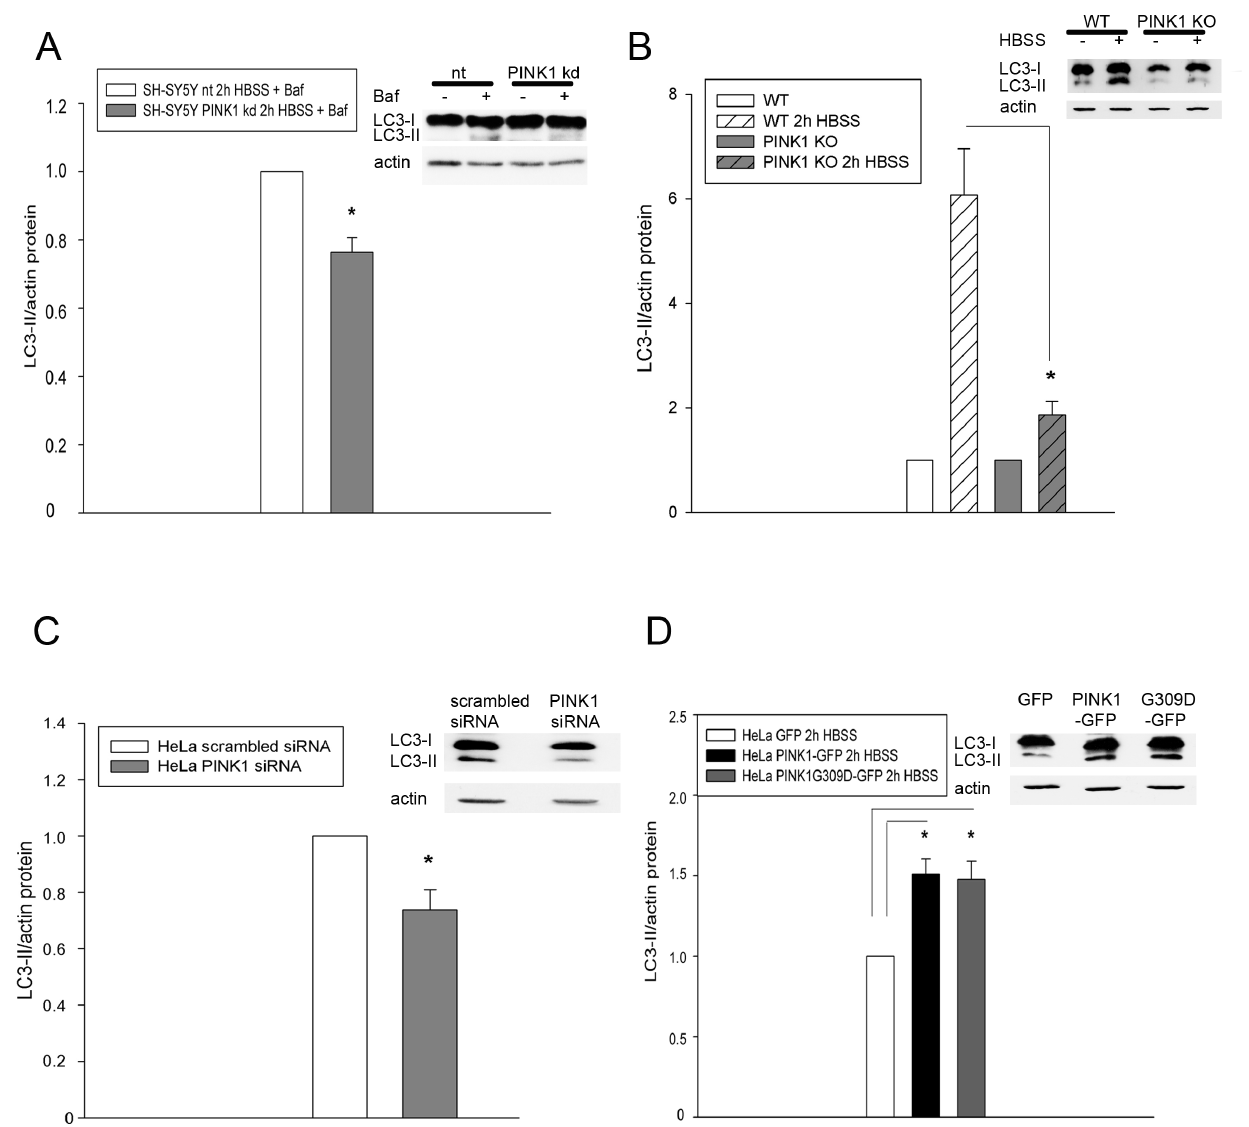
Figure 2. Reduced autophagy after PINK1 knockdown. 2A) SH-SY5Y cells were starved for 2 h in HBSS with Bafilomycin ( + Baf) or left untreated in RPMI + 5% FCS (- Baf). The LC3-II and actin content were determined by western blotting. A representative blot is shown on the right, showing only LC3-II bands in the Bafilomycin-treated samples. The LC3-II bands of Bafilomycin treated samples were normalized to actin and the relative LC3-II content of nt cells was set as 1. Cells with stable PINK1 knockdown exhibited a reduced LC3-II/actin ratio compared to the control (nt) cells; n=4, p , 0.005. 2B) Cortical neurons from 3 different isolations (10-20 DIV) of WT and PINK1 KO mice were either non-starved or starved for 2 h in HBSS and the LC3-II and actin content was determined by western blotting. A representative blot is shown on the right. The relative LC3-II content of WT and PINK1 KO mice, respectively, was set as 1. Primary neurons showed a strong upregulation of autophagy in reaction to starvation but cells derived from PINK1 KO mice exhibited a reduced LC3-II/actin ratio compared to the WT cells; n=5, p , 0.001. 2C) HeLa cells were transiently transfected with scrambled siRNA or PINK1 siRNA. After 48 h the LC3-II and actin content was determined by western blotting. A representative blot is shown on the right. The relative LC3-II content of cells transfected with scrambled siRNA was set as 1. Transient PINK1 knockdown resulted in a reduced LC3-II/actin ratio compared to the cells transfected with scrambled siRNA; n=6; p , 0.005. 2D) HeLa cells were transiently transfected with PINK1-GFP, PINK1G309D-GFP or GFP. After 24 h cells were starved for 2 h in HBSS. Afterwards the LC3-II and actin content were determined by western blotting. A representative blot is shown on the right. The relative LC3-II content of cells transfected with GFP was set as 1. Transient PINK1 or PINK1G309D overexpression resulted in an increased LC3-II/actin ratio compared to cells transfected with GFP; n=3, PINK1: p , 0.01; PINK1G309D: p , 0.05.